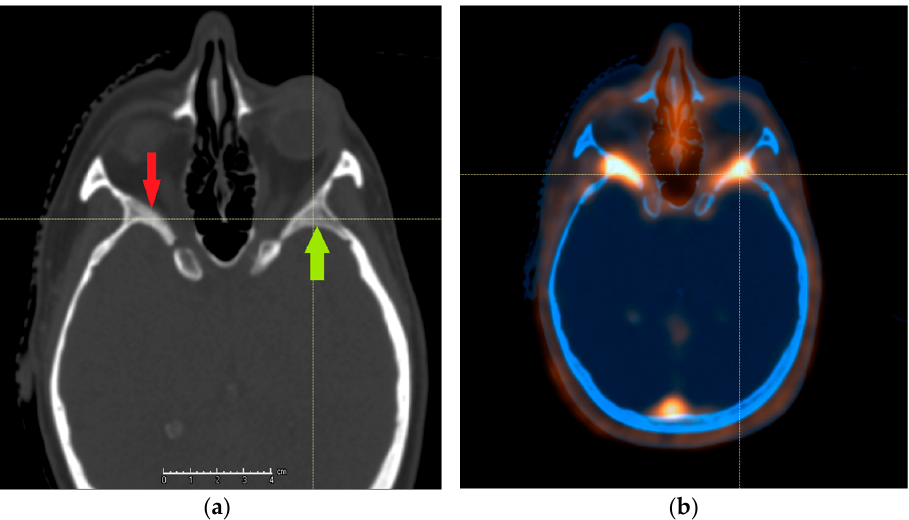
Figure 1. Example of an intraosseous extension of meningioma not properly recognized on CT: ( a ) the right side displays suspicious hyperostosis (red arrow), and the left side appears to have the normal bone structure preserved (green arrow). PET/CT revealed meningioma extension on both sides ( b